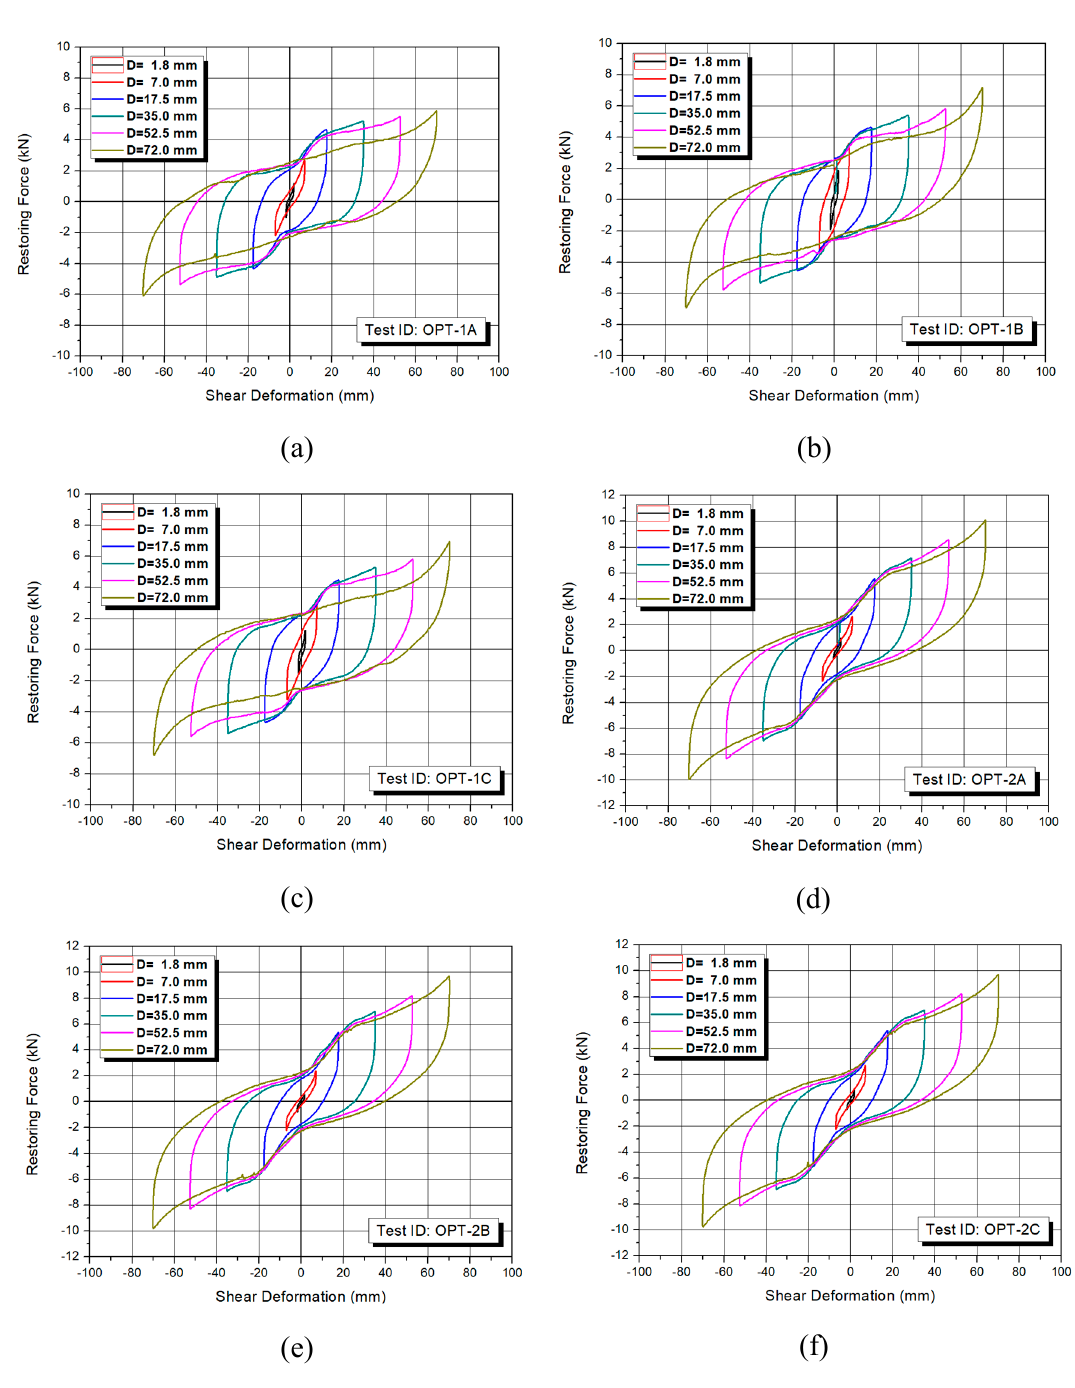
Figure 10. Test results of hysteretic characteristics for all test matrix: ( a ) OPT-1A; ( b ) OPT-1B; ( c ) OPT-1C; ( d ) OPT-2A; ( e ) OPT-2B; and ( f ) OPT-2C.